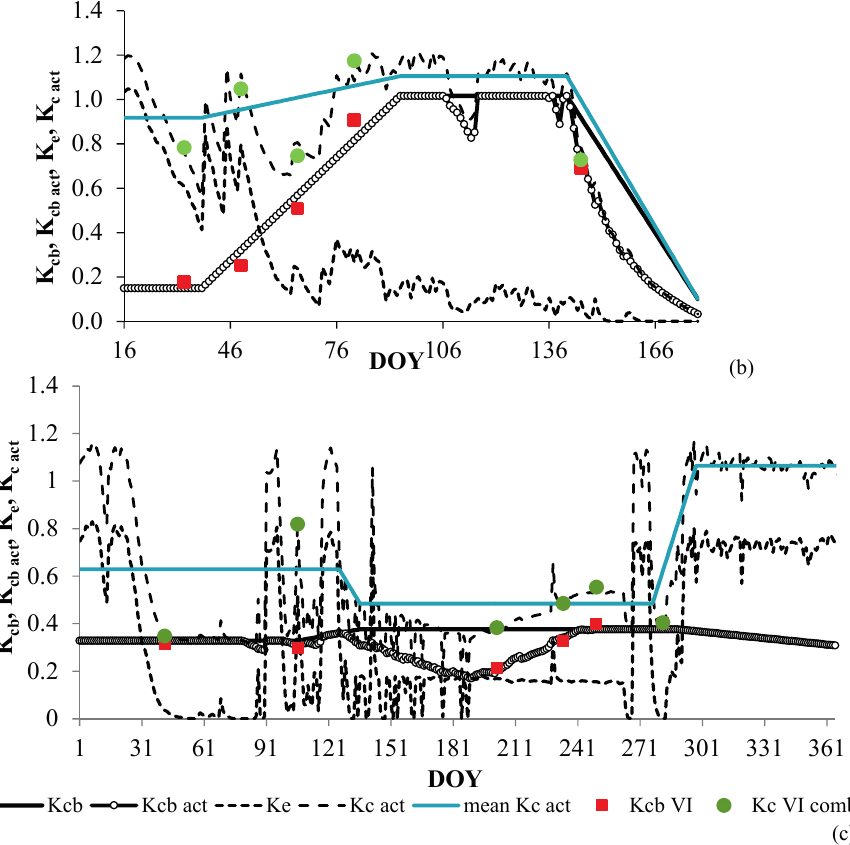
Figure 6. Seasonal variation of the daily coefficients K cb , actual K cb (K cb act ), K e and actual K c (K c act ) obtained with SIMDualKc, and actual K cb VI and actual K c estimated by the combined approach (K c VI ) for: ( a ) maize, field 1—Year 2010; ( b ) barley, year 2012; and ( c ) olive orchard, year 2012.